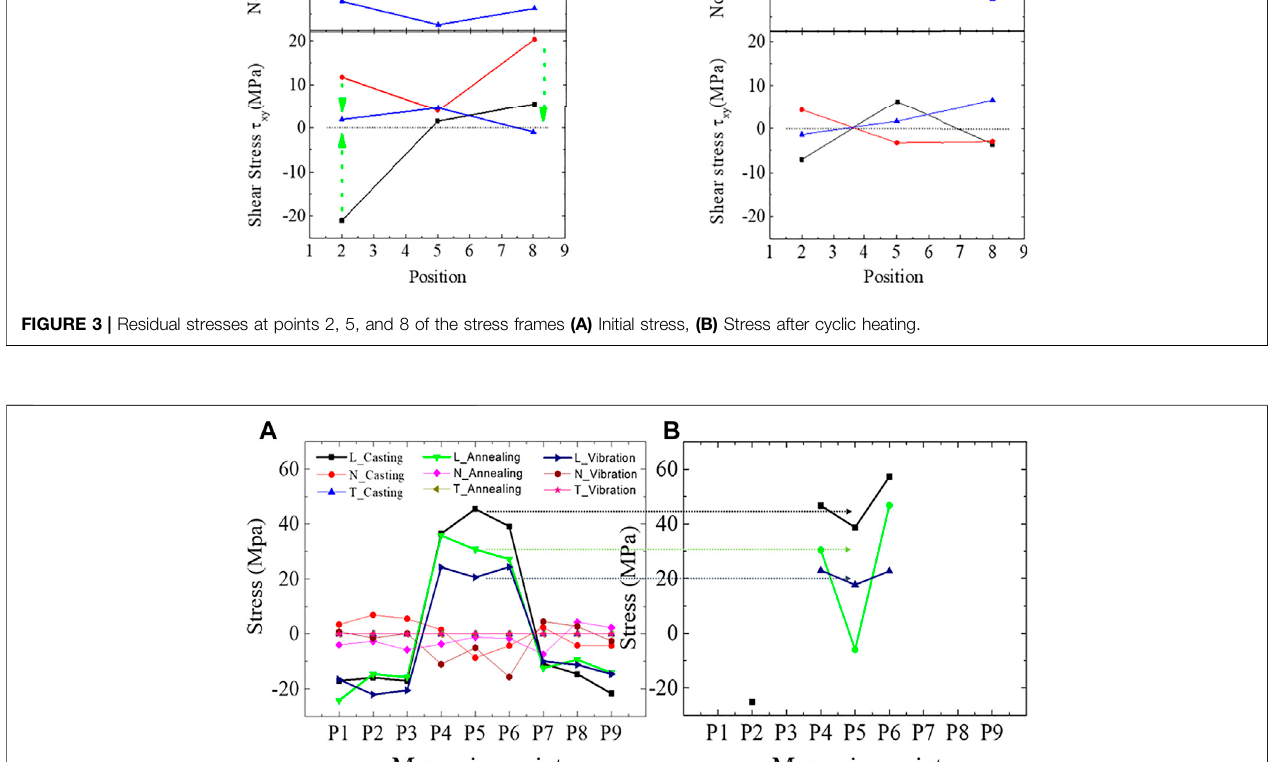
Figure 5 . Gray iron with the vibratory stress relief treatment